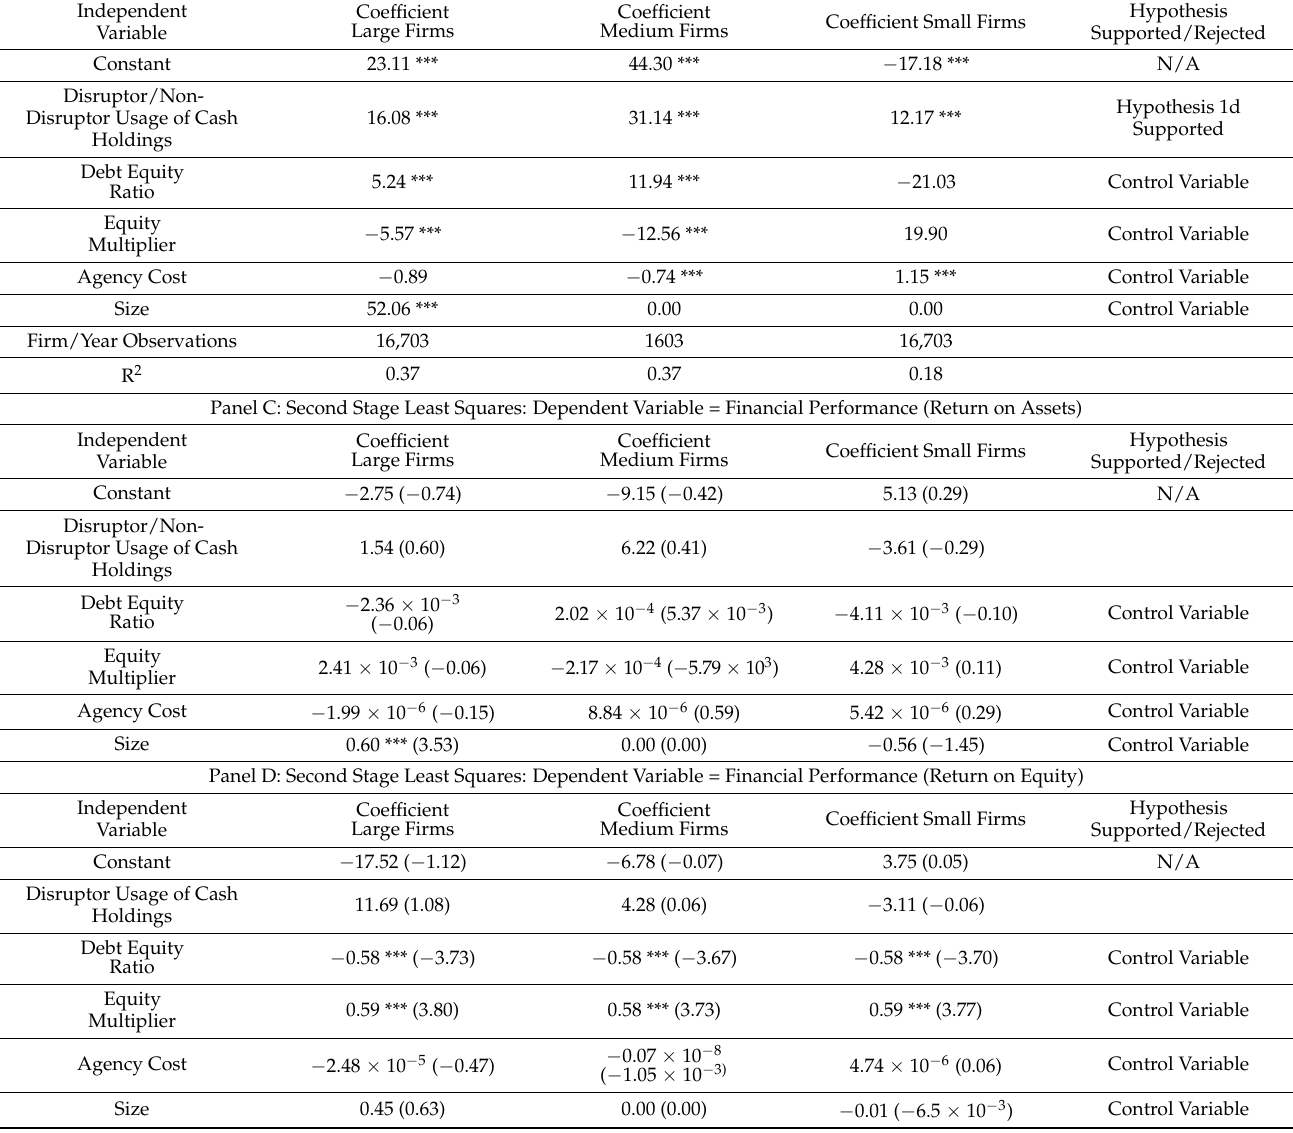
Table 6. Cont . Panel B: Second Stage Least Squares: Dependent Variable = Financial Performance (Security Returns)